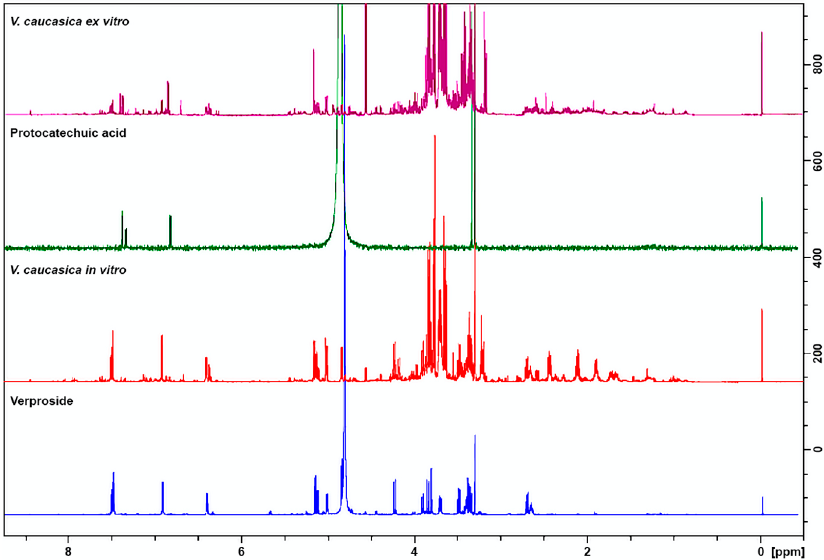
Figure 5. 1 H NMR spectra of in vitro cultivated and ex vitro adapted V. caucasica plants, pure verproside and protocatechuic acid. Table 2. Chemical shifts ( δ ) and coupling constants ( J ) of the metabolites identified in V. caucasica plants by their relevant 1D and 2D NMR